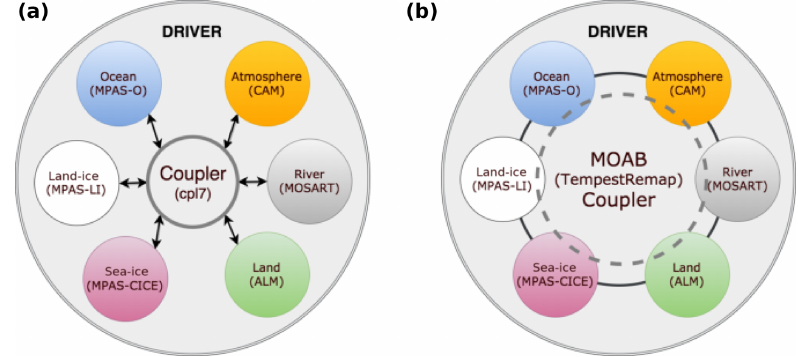
Figure 1. E3SM coupled climate solver: (a) current model; (b) newer MOAB-based